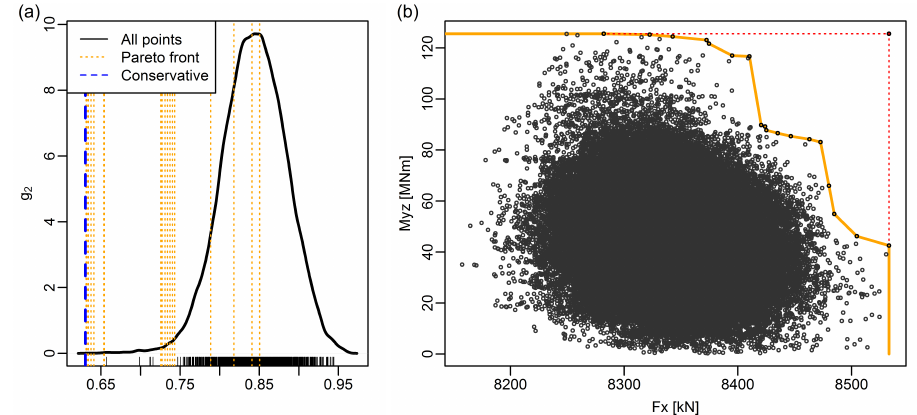
Figure 6. Results for the mudline location in the OC3 monopile at rated wind speed (DLC 1.3). ( a ) The distribution of the limit state function evaluated at all points in time. The broken blue line indicates the value for the conservative combination of univariate maxima. The dotted orange lines indicate the values for the Pareto-optimal points. The solid line is an estimate of the underlying distribution, i.e. , the theoretical case for an infinite number of samples. The actual samples from the time series are indicated with short black line segments at the bottom. ( b ) Scatter diagram showing axial force and bending moment. The Pareto-optimal front is indicated in orange. The single red point in the top right corner is the point obtained by the conservative approach.